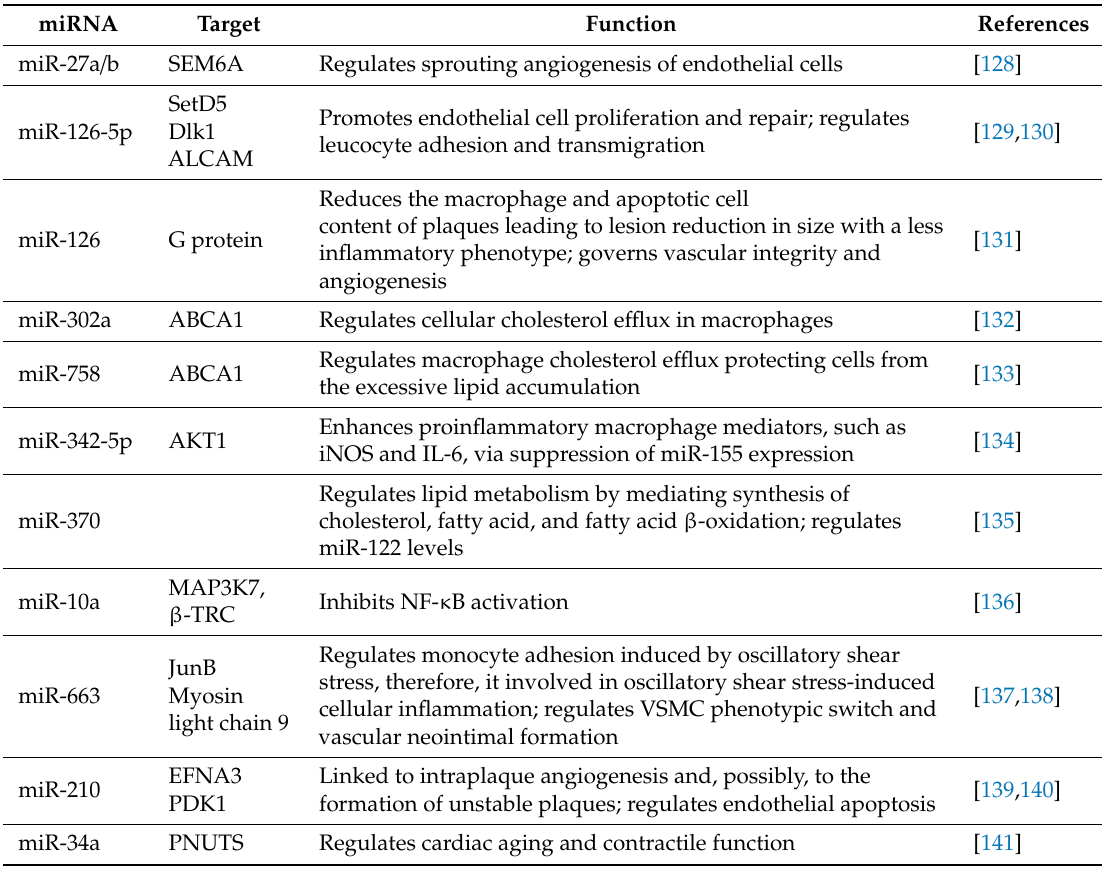
Table 1. miRNAs involved in the atherosclerosis